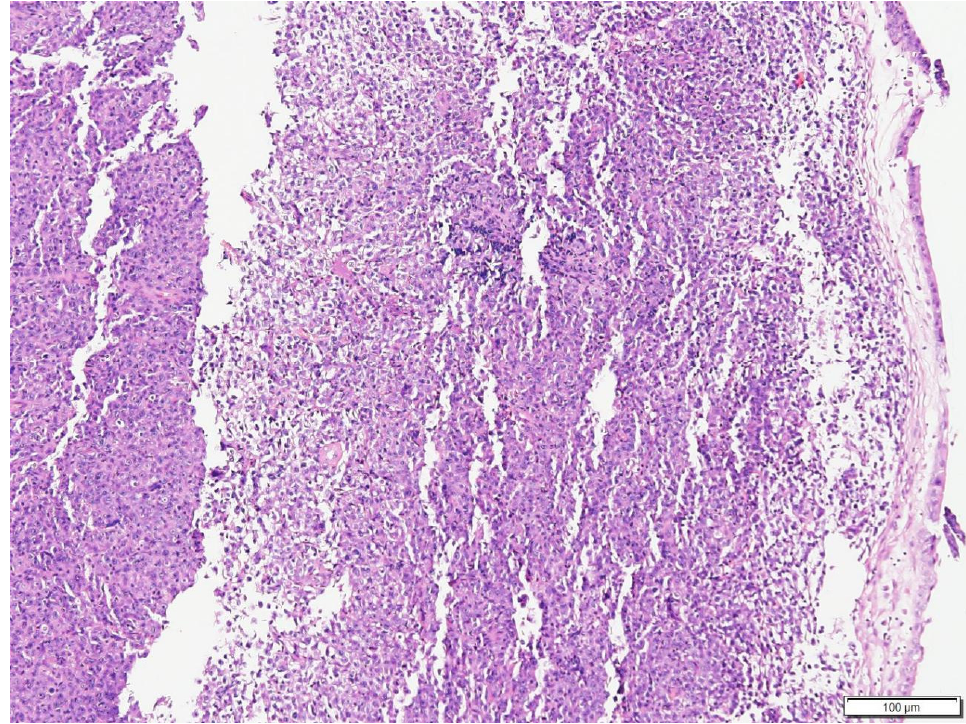
Figure 1. Histologic findings of the mass at the choanae of Case N.1. The submucosa is expanded by a neoplasm composed of solid sheets of round cells. Hematoxylin and eosin (H&E) stain (100× magnification).